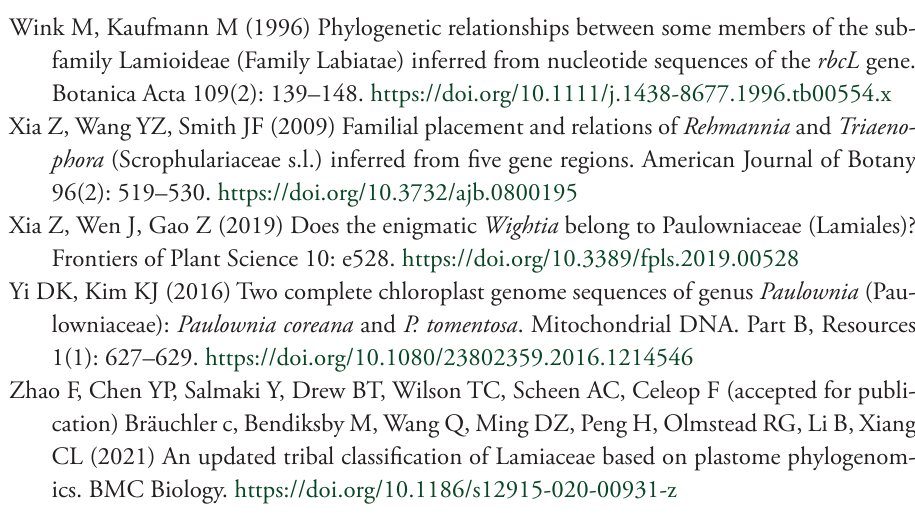
Explanation note: Figure S1. Bayesian Inference (BI) phylogram of Mazaceae based on the combined cpDNA dataset ( matK , rbcL , rps16 , and trnL-F ). Bayesian posterior probabilities are shown near the branches. Figure S2. Bayesian Inference (BI) phy- logram of Mazaceae based on the nrITS dataset. Bayesian posterior probabilities are shown near the